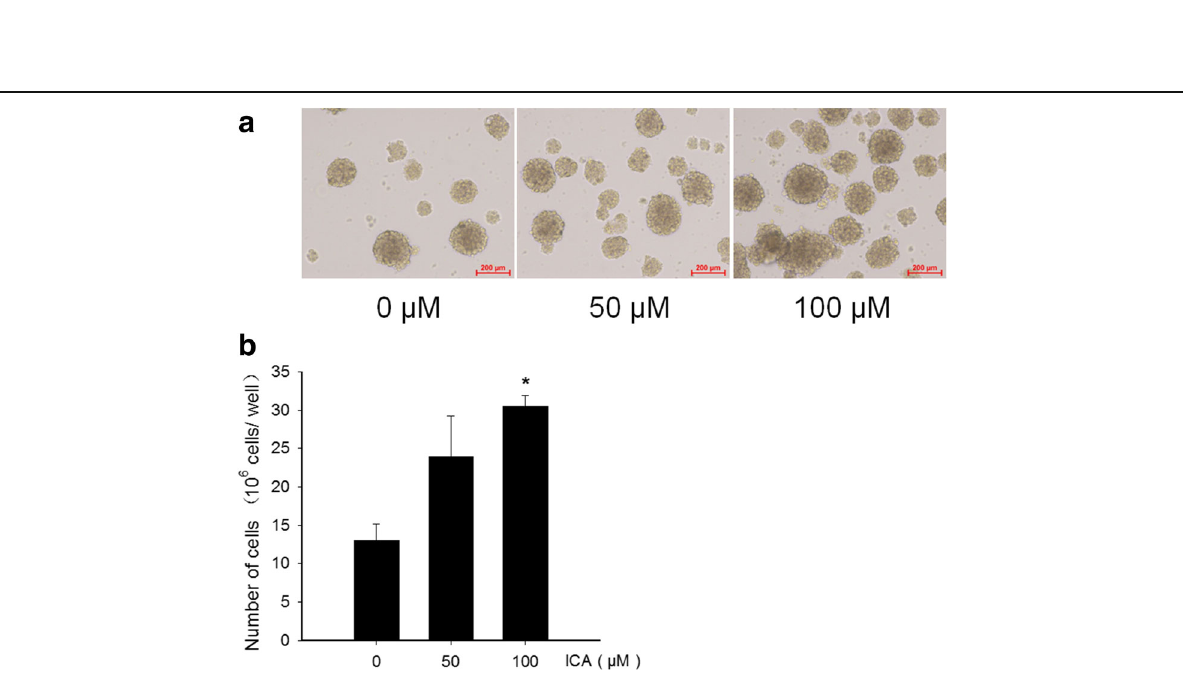
Fig. 3 Effect of ICA on the proliferation of NSCs. a Photomicrographic images were representative of control, 50 and 100 μ M ICA-treated rat hippocampal cultures. b Quantitation of NSCs under different concentrations of ICA treatment. Data are from three independent experiments, and the results are plotted as mean±SD of NSCs. * P <0.01 vs